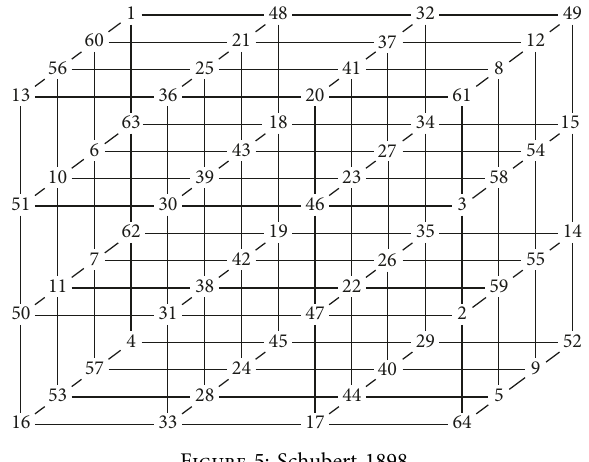
Figure 5: Schubert Figure 6. Next, we would like to find affine functions V , V , V , V , V , and V which define Figure 6. Since 1 2 3 4 5 6